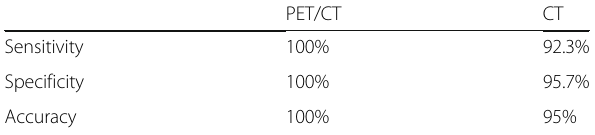
Table 3 Comparison between sensitivity, specificity, and accuracy of PET/CT and CT regarding detection of hepatic metastasis